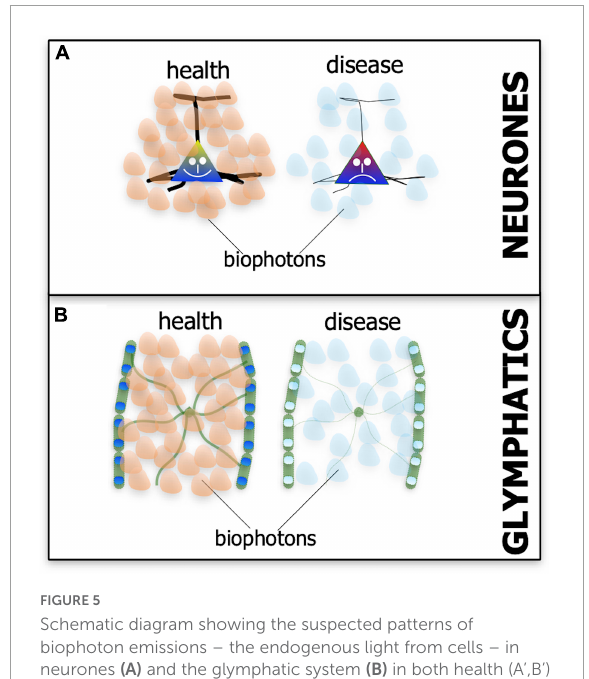
FIGURE5 Schematic diagram showing the suspected patterns of biophoton emissions – the endogenous light from cells – in neurones (A) and the glymphatic system (B) in both health (A’,B’) and disease (A",B"). In health, the biophoton light emitted by neurones and glymphatics may be different in terms of wavelength and intensity to that emitted in disease (represented by different-colored and fewer biophoton